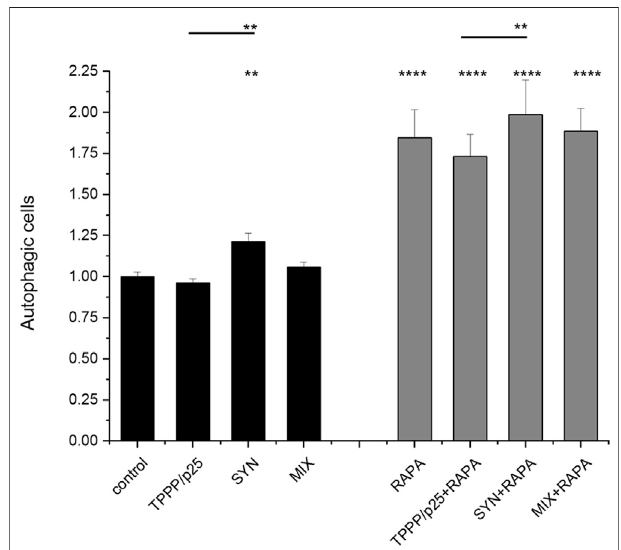
FIGURE 6 | In fl uence of SYN and/or TPPP/p25 on the autophagy fl ux in the LC3B expressing-HeLa cells as detected by FACS. The concentrations of TPPP/p25 and SYN were 80 nM and 800 nM, respectively; the concentration of rapamycin (RAPA) is 1 μ g/ml. Data are normalized with respect to control(noautophagymodulators)andpresentedasthemean ± SDofatleast 4 independent experiments. Statistical comparisons were performed with two-way ANOVA followed by Tukey ’ s test, * p < 0.05, ** p < 0.01 and **** p < 0.0001 as compared to control or as the lines